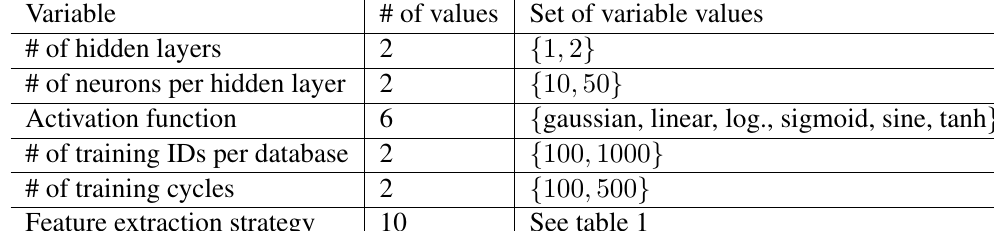
Table 2: The six variables for the configuration of the neural network models. The variables num- ber of hidden layers and number of neurons per hidden layer regard the neural network structure, the variable type of activation function regards the signal processing of the neural networks, the variables number of identifiers per database and number of training cycles regard the neural net- work training, and the variable feature extraction strategy regards the generation of the neural network